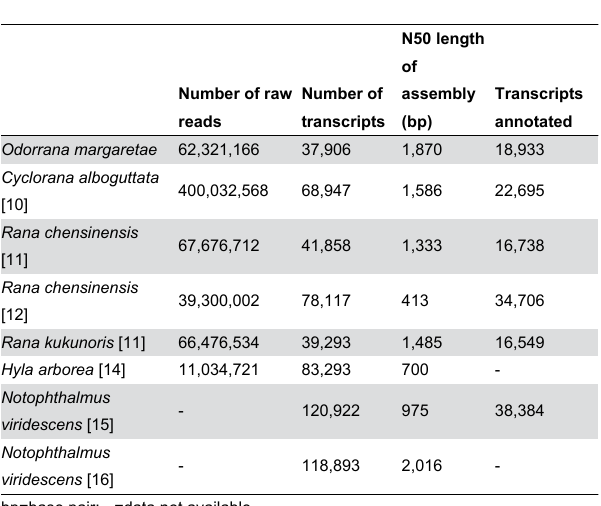
Table 2. Comparison of transcriptome data for six amphibian